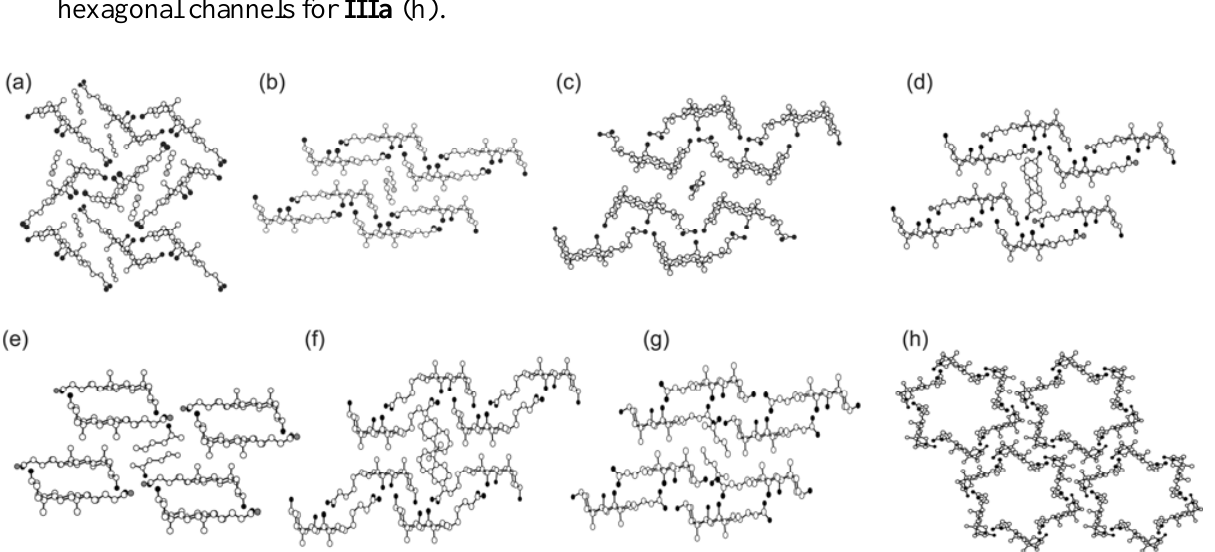
Figure 2. Representative crystal structures of steroidal bile acids and their derivatives; a crossing structure with cage-like cavities for Ia (a), bilayered structures with channel-like cavities for Ia (b), IIa (c), Ib (d), IVb (e), If (f), Ig (g), and a honeycomb structure with hexagonal channels for IIIa